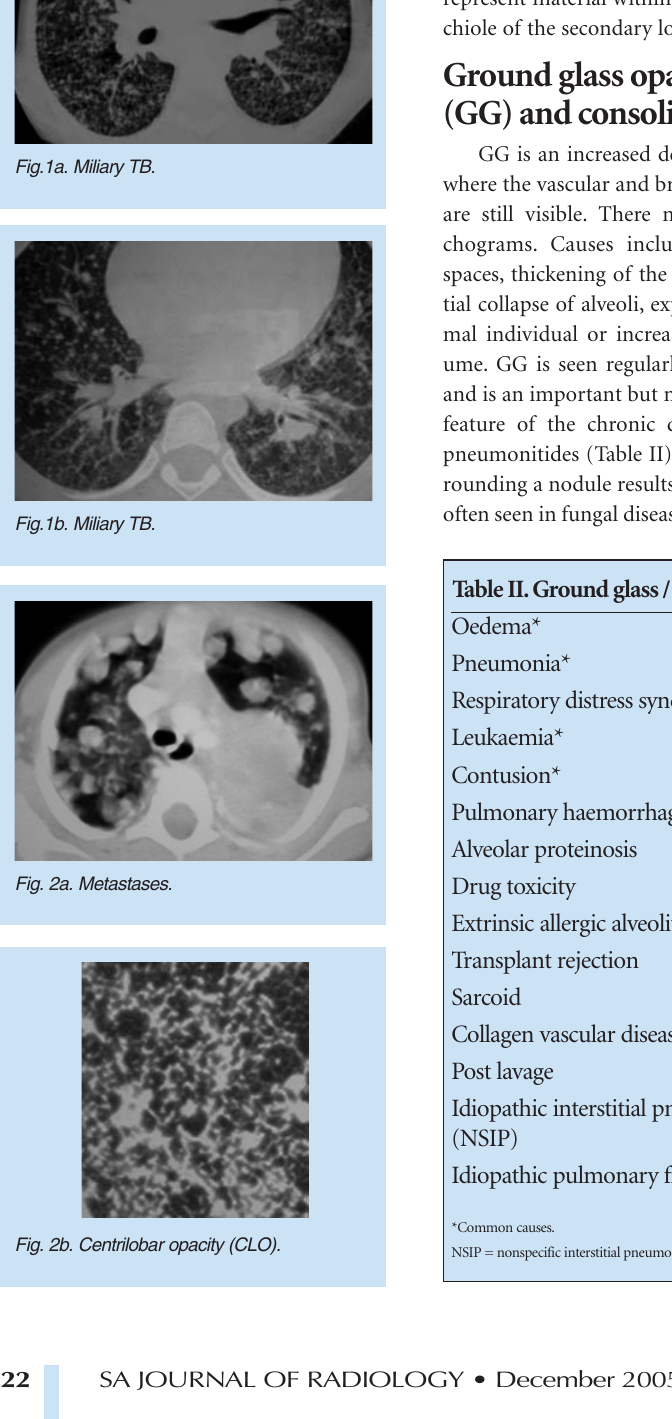
Fig. 3. Ground glass (GG).